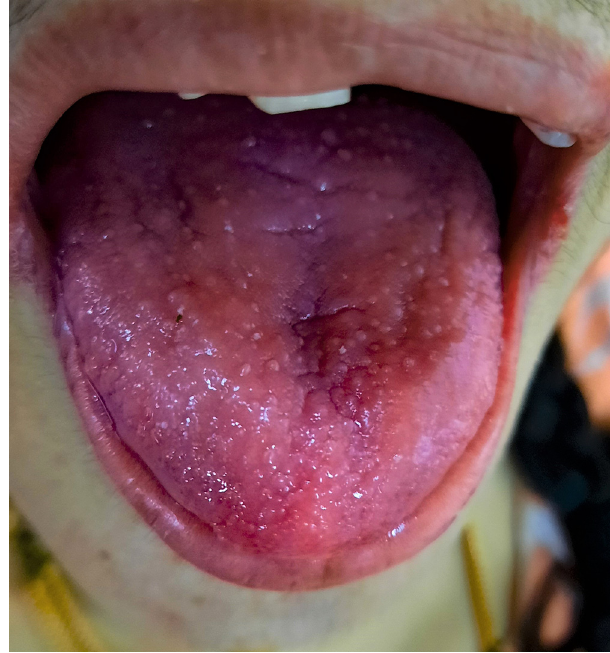
Fig. 1. Bald and erythematous tongue with sparse hypertrophic papilla giving appearance of strawberry tongue. * Correspondence: